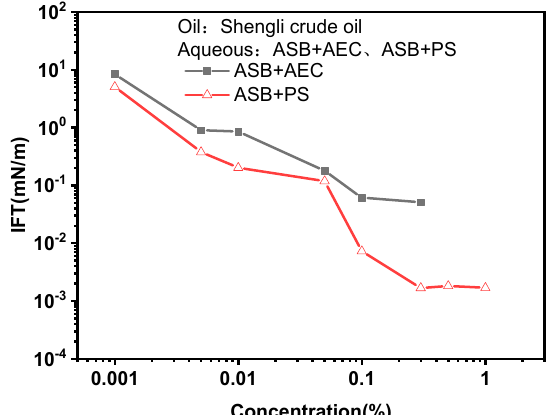
Figure 6. Effect of concentration on equilibrium IFTs of ASB@PS and ASB@AEC solutions against Shengli crude oil.